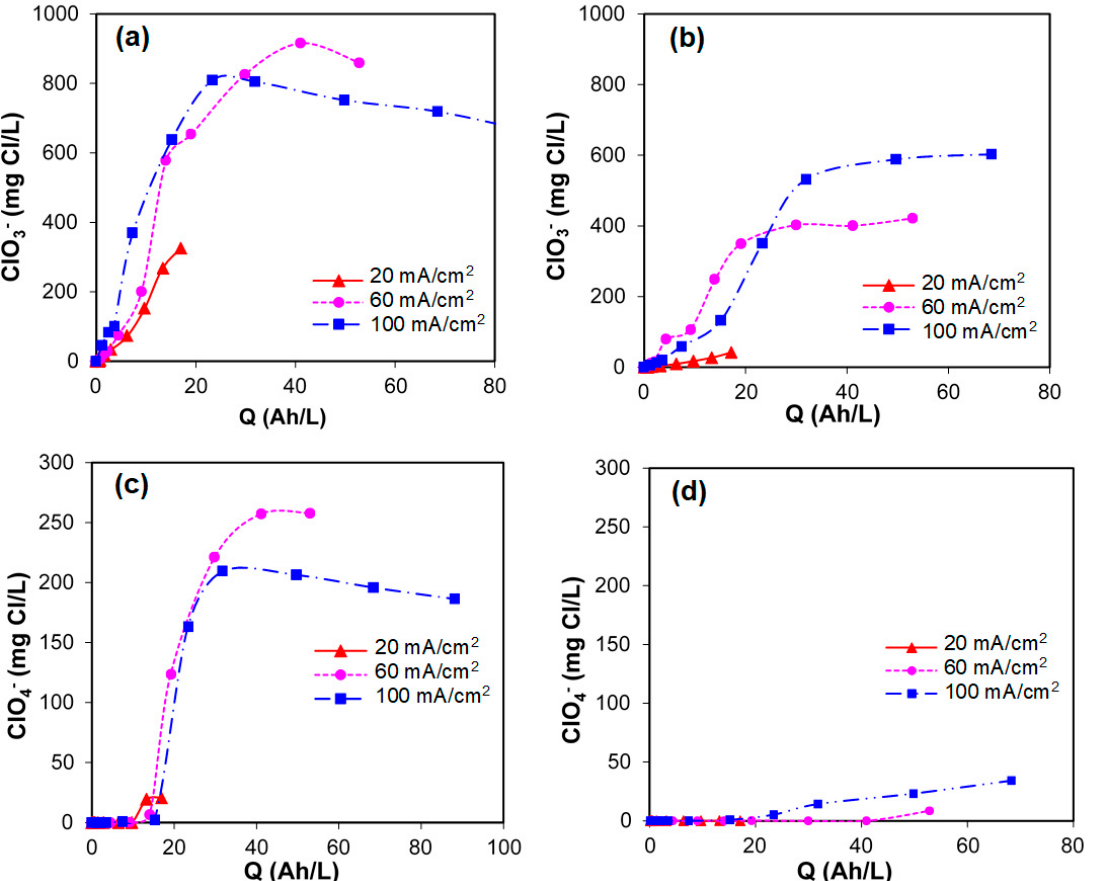
Figure 8. Changes in the concentrations of ( a , b ) chlorates (ClO 3 − ) and ( c , d ) perchlorate (ClO 4 − ) formed with the specific electric charge during electrolytic treatment of synthetic urine at pH = 5.5 and at room temperature (25 °C) using BDD ( a,c ) and DSA ( b,d ) anodes and a stainless steel cathode with a flow rate of 800 mL/min at different current densities: ( ▲ ) 20 mA/cm 2 , ( ● ) 60 mA/cm 2 , and ( ■ ) 100 mA/cm 2.